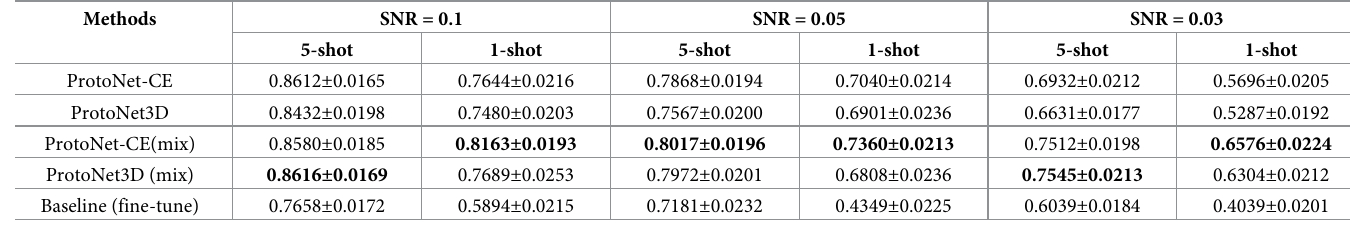
Table 1. The classification accuracy of the simulated datasets. 5-shot is short for 5-way 5-shot and 1-shot is short for 5-way 1-shot. The suffix (mix) means that the model is trained on a dataset with mixed SNR. Methods SNR = 0.1 SNR =